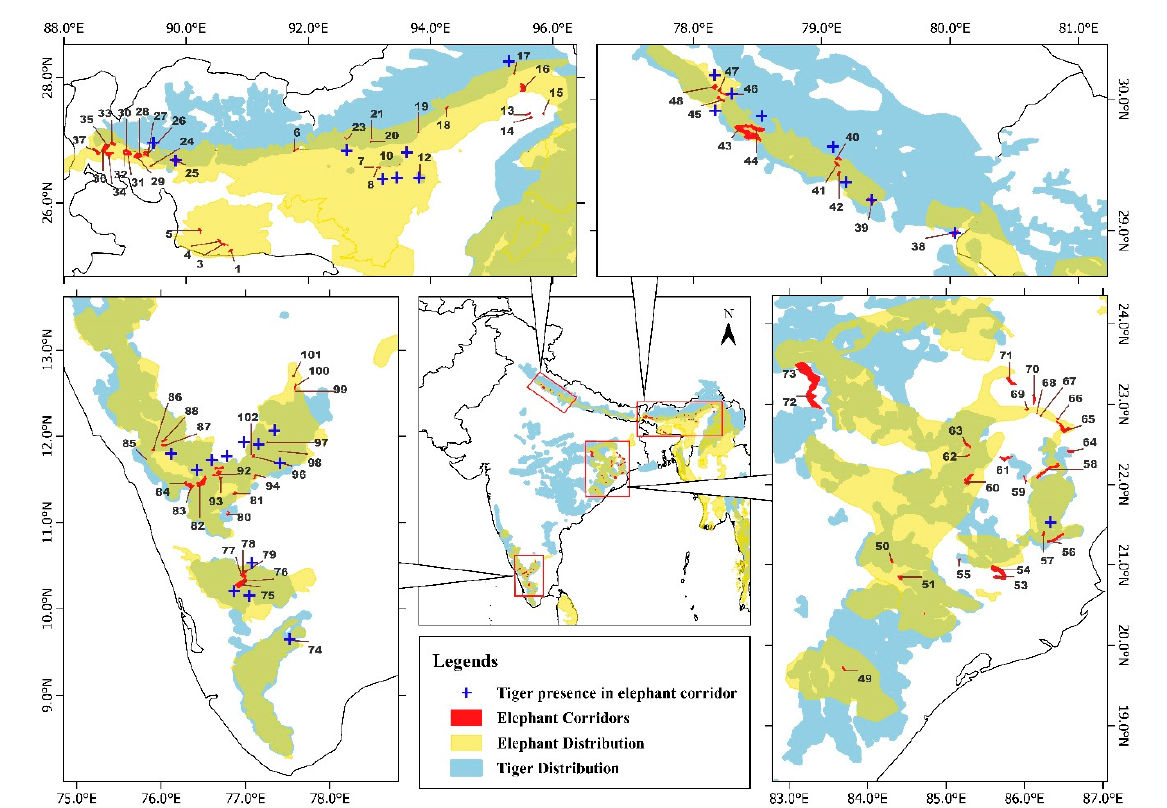
Figure 6. Map showing elephant corridors and presence of tigers in India (Appendix A). Table 3. Details of tiger presences in elephant corridors (* see Appendix A for further details).